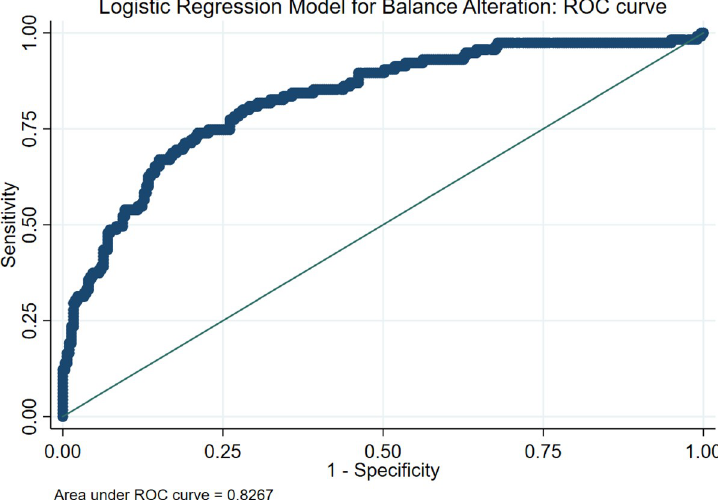
Where the β are the regression coefficients (given in Table 3), and the X i model variables with i = 0, 1, 2, 3, and 4: the constant of the regression, MVELAPOE_DIC,